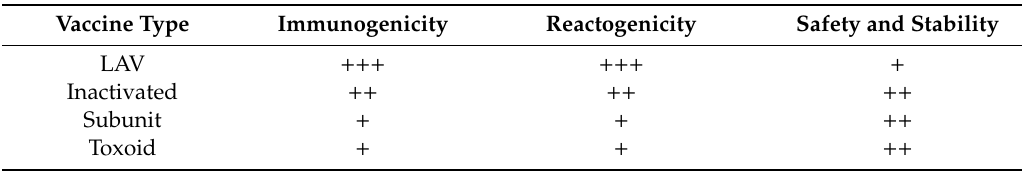
Table 1. Comparison of commonly used vaccine